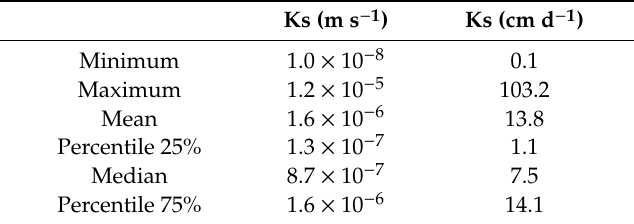
Table 1. Statistics of the measured saturated hydraulic conductivity using the slug test in 36